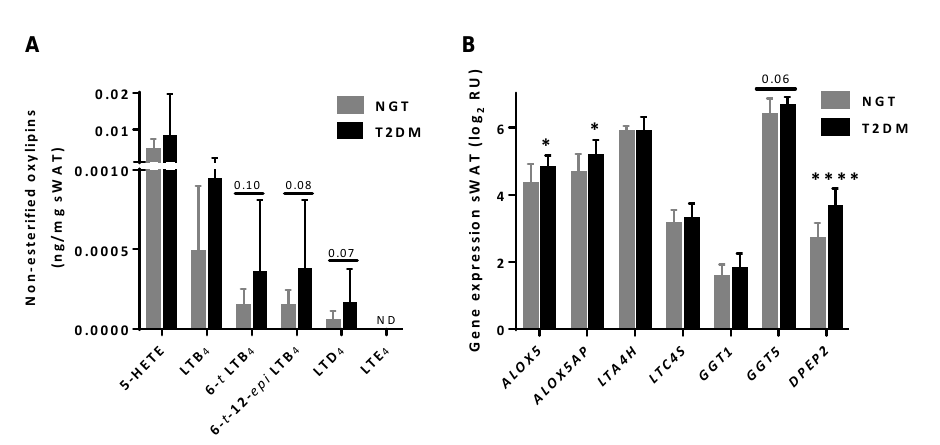
Figure 3. 5-LOX oxylipins in white adipose tissue (sWAT). ( A ) Non-esterified oxylipins derived from arachidonic acid via the 5-LOX pathway in sWAT of normal glucose tolerance (NGT) versus type 2 diabetes mellitus (T2DM) obese individuals. LTE 4 was below the detection limit (ND not detectable). LTA 4 , LTC 4 , and LTF 4 were not included in the LC-MS/MS method. ( B ) Gene expression of genes involved in the leukotriene biosynthesis pathway in sWAT of NGT versus T2DM individuals ( ALOX5 , ALOX5AP , LTA4H , LTC4S , GGT1 , GGT5 , and DPEP2 ). Data are log transformed normalized gene expression levels (relative units [RU]: log2-scale). Data are expressed as mean ± standard deviation (SD). * p < 0.05 and **** p < 0.0001 for NGT versus T2DM.